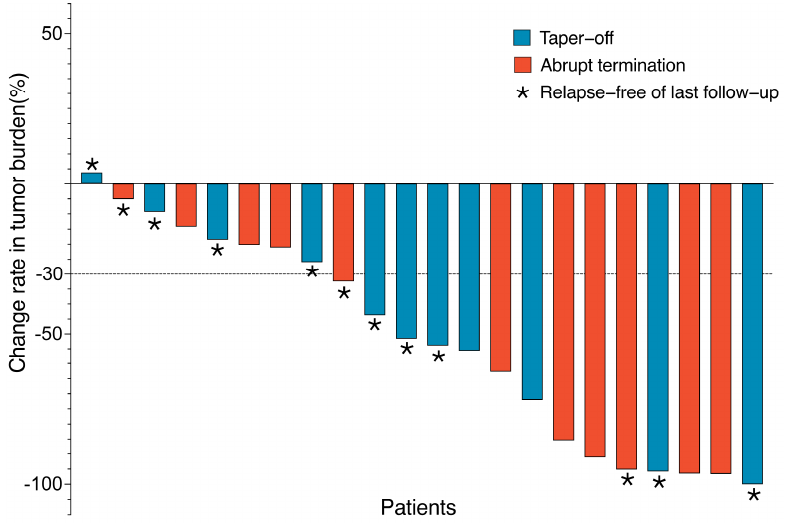
Figure 3. Change rate from baseline of the total tumor burden. Each bar represents one patient ( n = 22). * These patients were disease-free in last follow-up by surgery or radiofrequency ablation. Red bars represent patients who discontinued TKI by tapering off, and the blue represents those with abrupt termination. Dashed lines indicate RECIST criteria for progressive disease (+20%) or partial response ( − 30%).